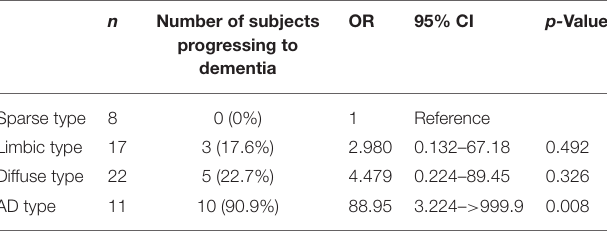
TABLE 4 | Conversion to dementia in each MCI subgroup.